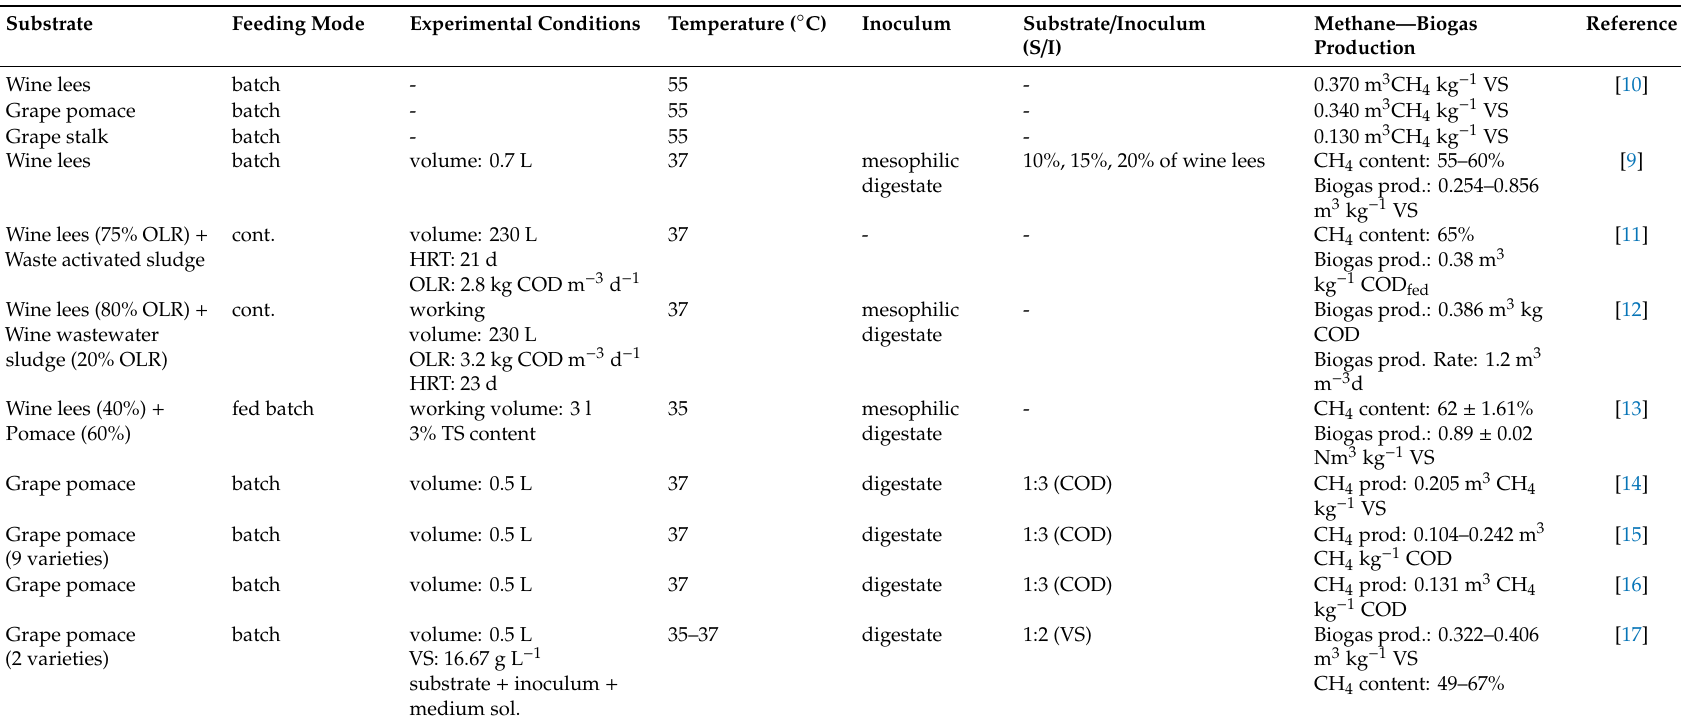
Table 1. Overview of literature studies exploring anaerobic digestion (AD) of wine-making industry wastes. Reporting the volume of the reactor, hydraulic retention time (HRT), organic loading rate (OLR), conditions of the digestion and gas production reported by the